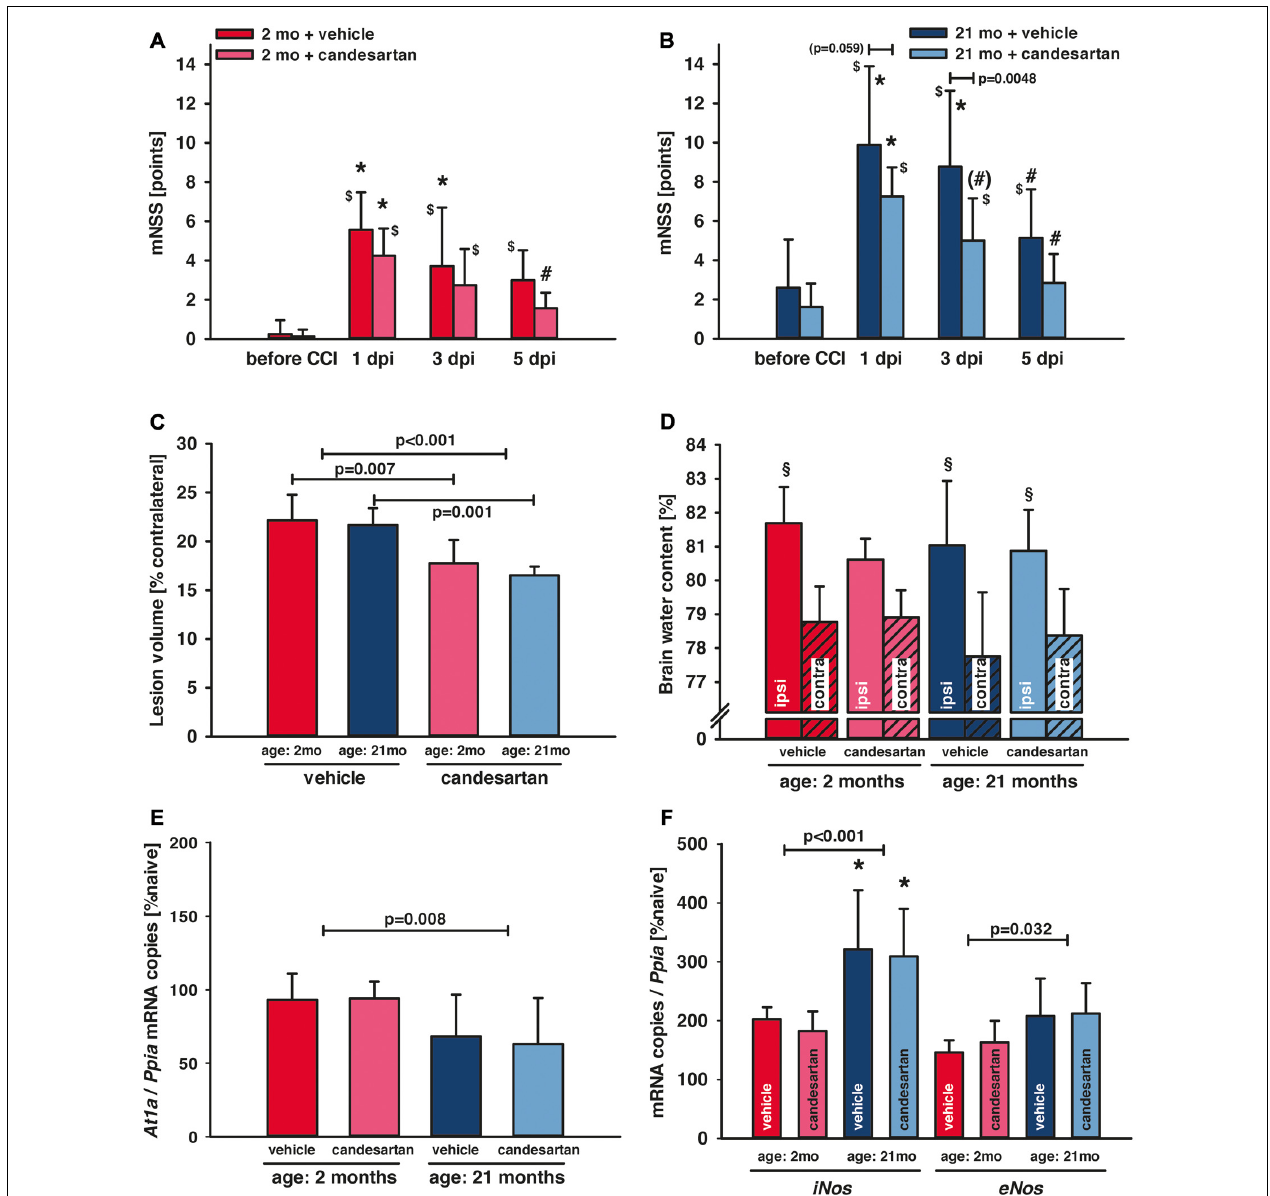
FIGURE 2 | Influence of AT1 inhibition on posttraumatic neurological function, brain damage and brain edema formation. (A,B) Neurological assessment was performed before and 1, 3 and 5 days after controlled cortical impact (CCI; 1, 3, 5 dpi) using a modified Neurological Severity Score (mNSS). One day after traumatic brain injury (TBI; 1 dpi) there was a marked neurological impairment in all groups with increased mNSS in old compared to young mice ( ∗ p < 0.05 old vs. young) and with lasting elevation of the mNSS in vehicle-treated mice ( $ p < 0.05 vs. before CCI). In candesartan-treated young mice there was a neurological recovery with decreasing mNSS at day 5 ( # p < 0.05 vs. 1 dpi). In aged mice, in both treatment groups, mNSS was lower at 5 dpi compared to 1 dpi. However, there was a trend towards faster recovery in candesartan-treated old mice already on day 3 ( ( # ) p = 0.07). At 3 dpi candesartan treatment reduced neurological impairment compared to vehicle-treatment in old mice ( p < 0.05). There was a trend in candesartan-treated aged mice to lower impairment already at 1 dpi compared to vehicle treated old mice. After the 5-day observation period, brain lesion volume (C) was reduced in candesartan-treated mice in both age groups [ p < 0.05; young: vehicle and candesartan ( n = 8 each); old: vehicle ( n = 10; seven survived) and candesartan ( n = 8; seven survived)]. (D) In a separate set of animals, brain water content was quantified 1 day after the injury. In contrast to vehicle-treated and old mice, in young candesartan-treated mice brain water content ipsilateral to the lesion was not significantly different to contralateral water content ( § p < 0.05 vs. contralateral; young vehicle and candesartan, n = 8; old vehicle and candesartan, n = 7). Five days after TBI expression of At1a (E) , iNos and eNos (F) were determined by qPCR. At1a levels were significantly lower in aged animals. iNOS and eNOS showed increased levels in old compared to young mice [ ∗ p < 0.05 old vs. young; candesartan: young ( n = 8); old ( n = 7) or vehicle young ( n = 8); old ( n = 7)]. At1a , iNos and eNos expressions were not altered by treatment. Young animals (2 months, 2mo) are presented in red (dark red: vehicle, light red: candesartan) and old animals (21 months, 21mo) in blue (dark blue: vehicle, light blue: candesartan). Two-way ANOVA with Holm-Sidak’s multiple comparisons test (data is presented as mean ± SD; p < 0.05).